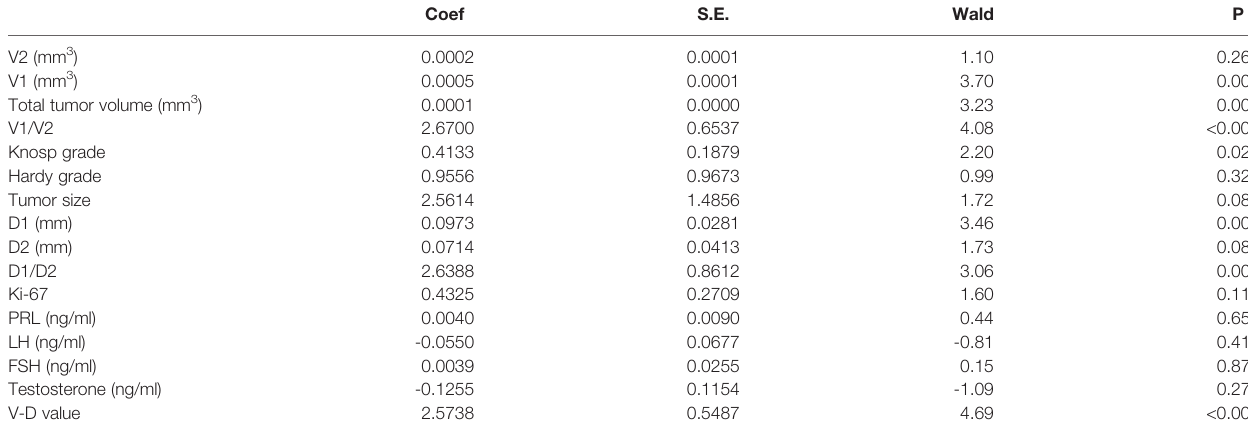
TABLE 3 | Univariate Logistic regression between recurrence and multiple factors. Coef